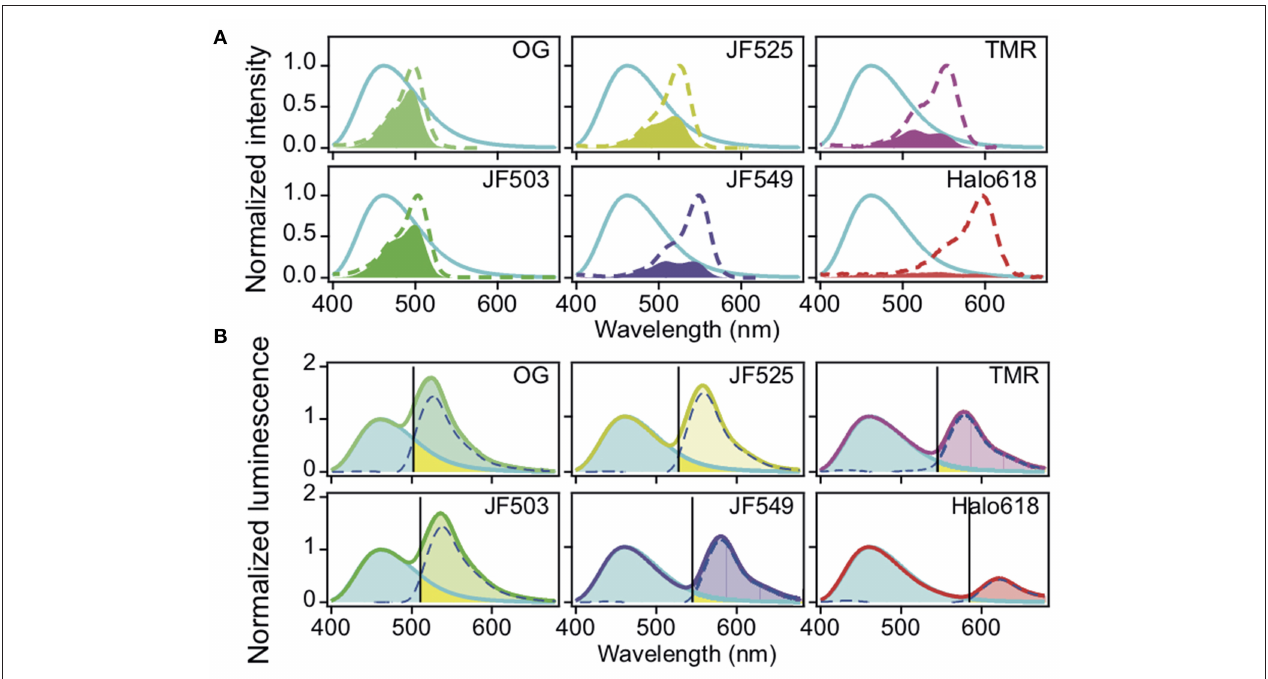
FIGURE 1 | Spectra of NanoLuc and HaloTag ligands. (A) Normalized absorption spectra of HaloTag ligands. The spectra of the different ligands are in dotted lines (OG, bluish green, JF503, yellowish green, JM525, yellow, JF549, violet, TMR, purple, Halo618, red) and overlaid with the normalized luminescence spectrum of NanoLuc (cyan solid line). The filled region indicates the overlap area (the products of two spectra). (B) Luminescence spectra of Halo-NanoLuc conjugated with Halo-ligands. Spectra were normalized with the donor peak at 460nm. Dotted blue lines indicate the acceptor spectrum calculated by subtracting the spectrum for only NanoLuc (cyan) from that with the ligand. The wavelength where the acceptor spectrum intersects the NanoLuc spectrum (S D : A ) is denoted with a black line. R bt is the ratio of yellow area over sum of yellow and cyan areas, whereas F D is the ratio of yellow area over sum of the yellow area and the area colored with the color code of respective ligands.